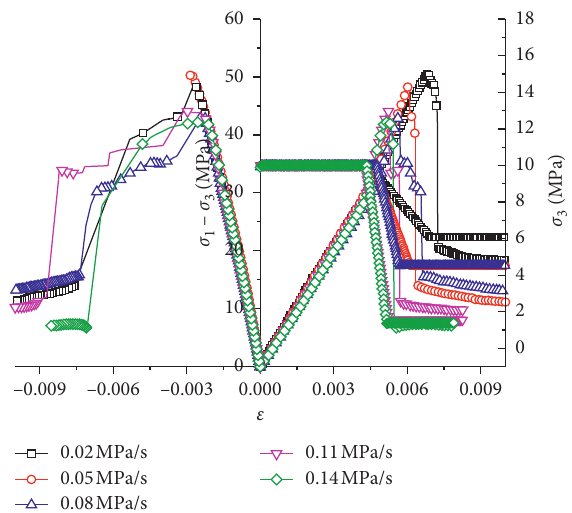
Figure 6: Stress-strain curve of coal samples under different confining pressure unloading